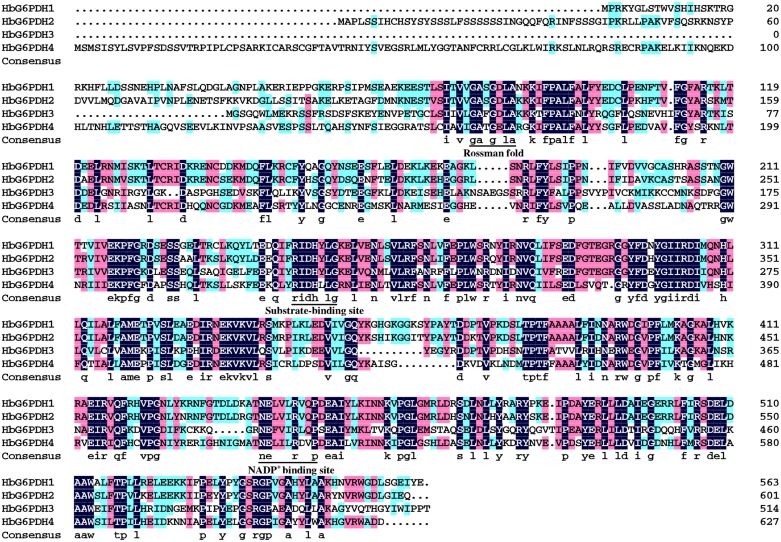
Amino acid sequence alignment of the four Hevea brasiliensis glucose-6-phosphate dehydrogenase (HbG6PDH) isoforms. Strictly conserved sequences are in white on black background; similar amino acids are in black on red and blue backgrounds. The conserved Rossman fold, substrate-binding site, NADP+ binding site were underlined.